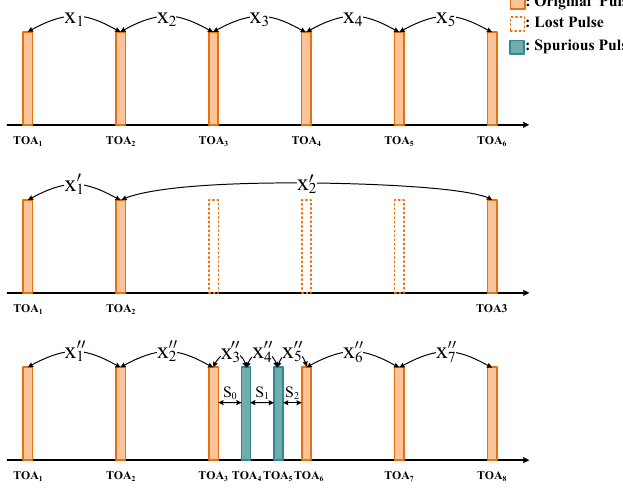
Figure 2. Example of lost and spurious pulse conditions.